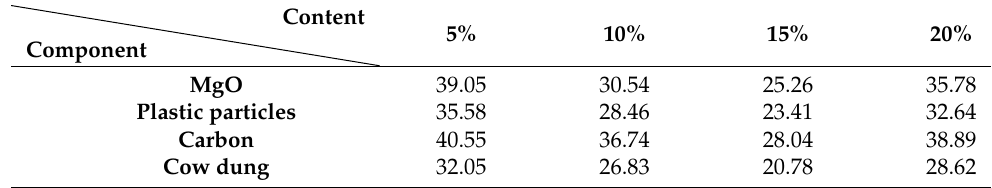
Table 8. Sticking ratio of Newman ore with different coating materials and